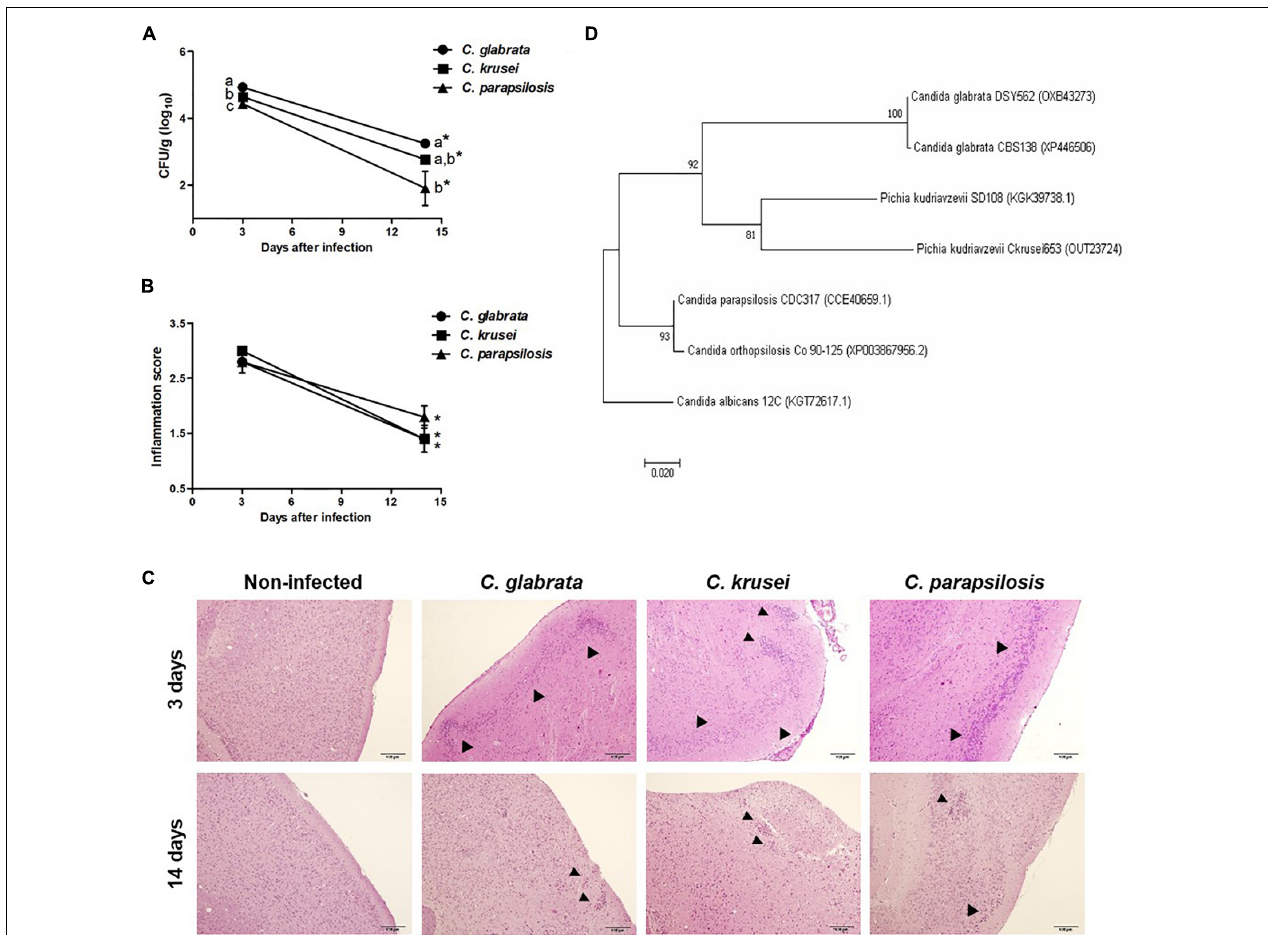
FIGURE 1 | Non- albicans Candida dissemination to the brain in immunocompetent mice. Brain fungal load (A) , inflammation score (B), and inflammatory infiltration (C) of Candida glabrata , Candida krusei, and Candida parapsilosis in brain samples were evaluated at 3 and 14 days after infection. The results are expressed as mean ± SEM; ∗ indicate statistical difference between 3 and 14 days analyzed by unpaired t -test; different letters indicate statistical difference among groups analyzed by One-way ANOVA with post hoc Tukey test; p < 0.05; n = 5/group. Arrowheads indicate diffuse inflammatory infiltration and focus of inflammatory infiltration. Phylogenetic construction of SSA1 protein (D) for C. glabrata , C. krusei ( Pichia kudriavzevii ) and C. parapsilosis . The percentage of trees in which the associated taxa clustered together is shown next to the branches.